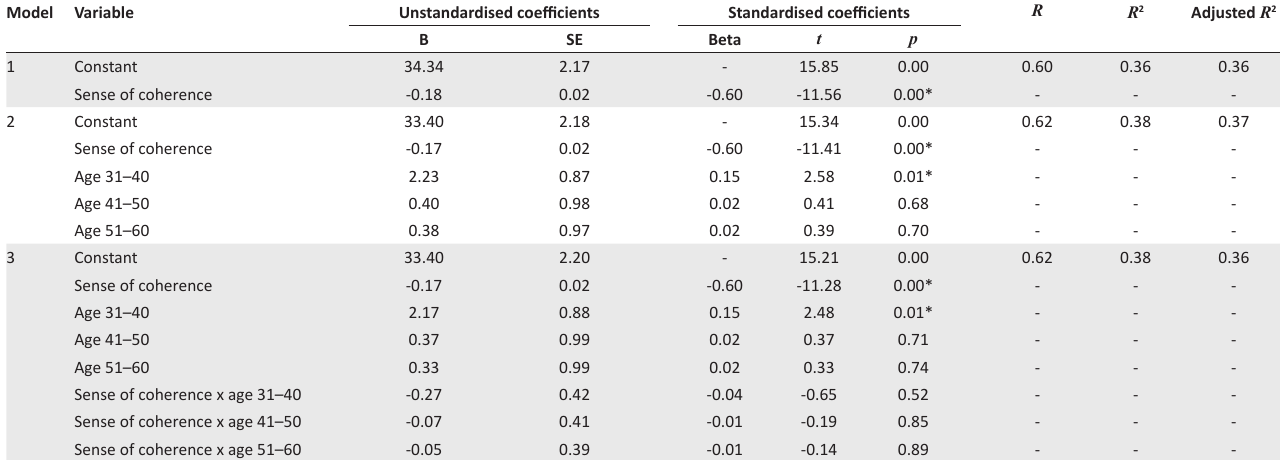
TABLE 5: Moderated multiple regression with cynicism as the dependent variable. Model